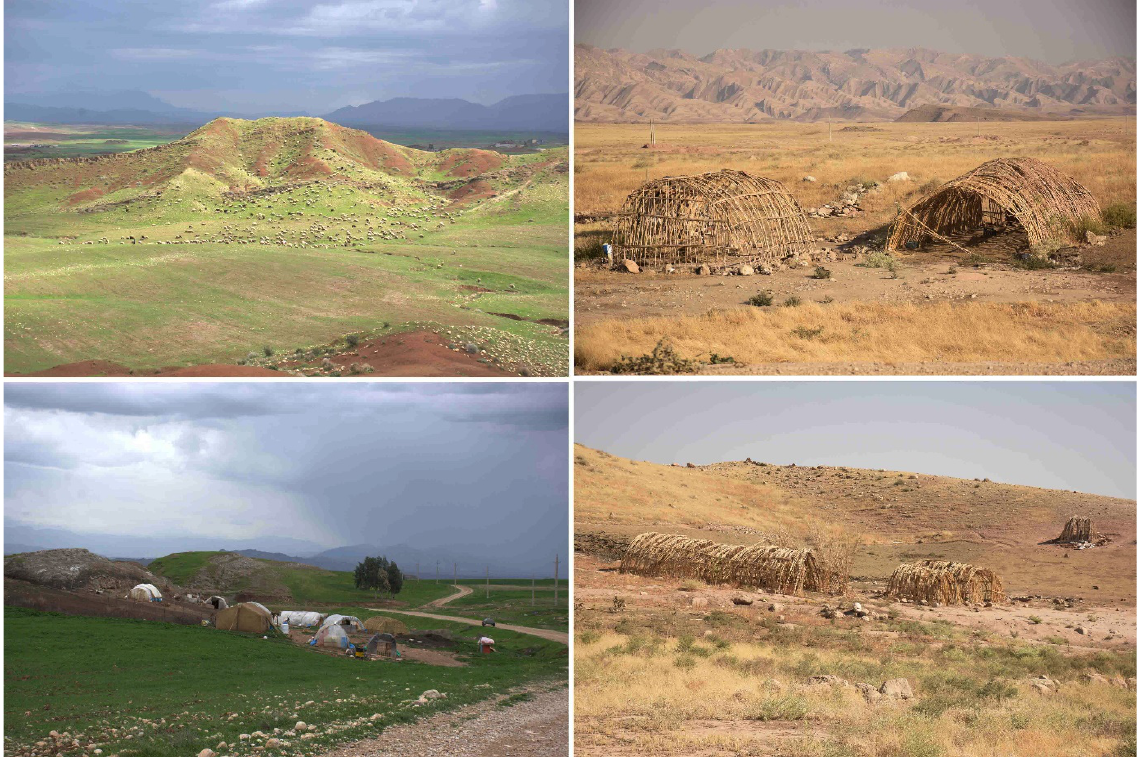
Figure 1. Nomad camps in Western foothills of Zagros mountain, Qasr-e Shirin and